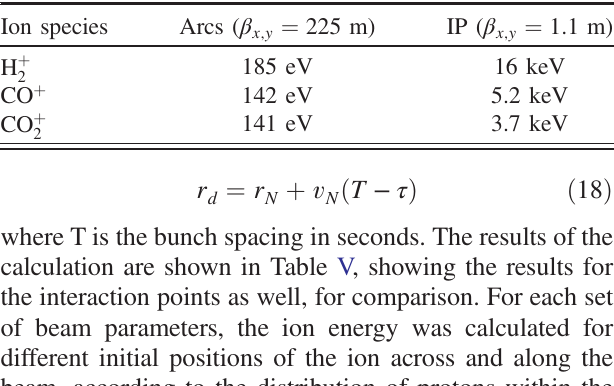
TABLE V. Average ion energies for different beam sizes, without magnetic field presence. β is the beta function.